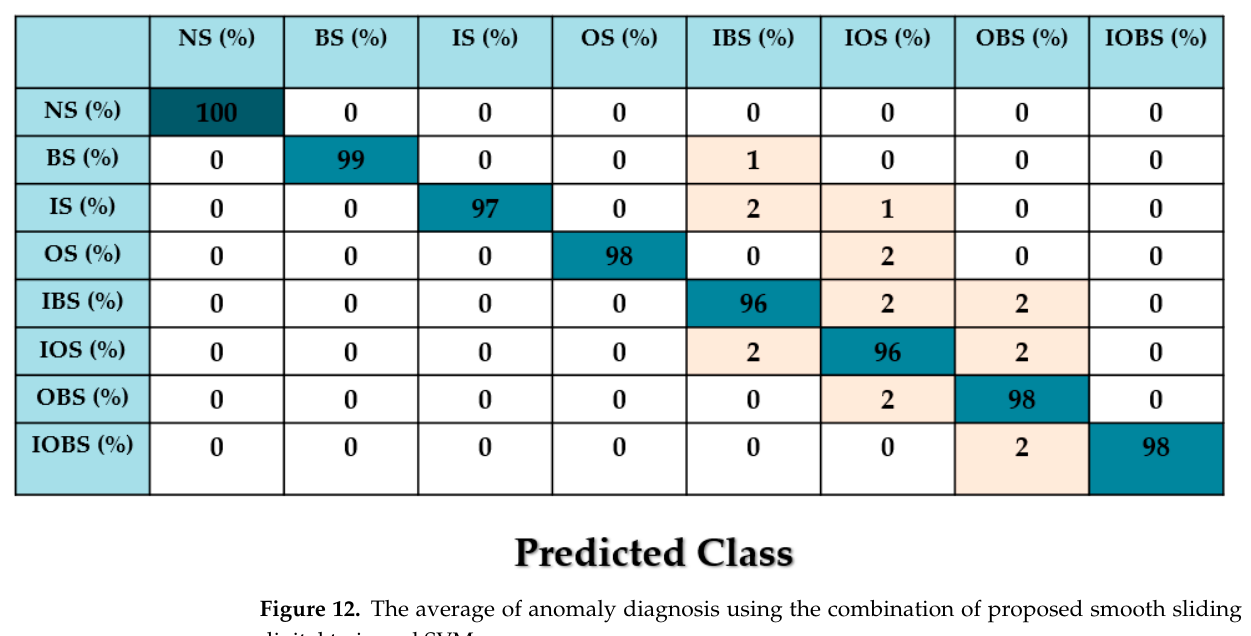
Figure 12. The average of anomaly diagnosis using the combination of proposed smooth sliding digital twin and SVM.